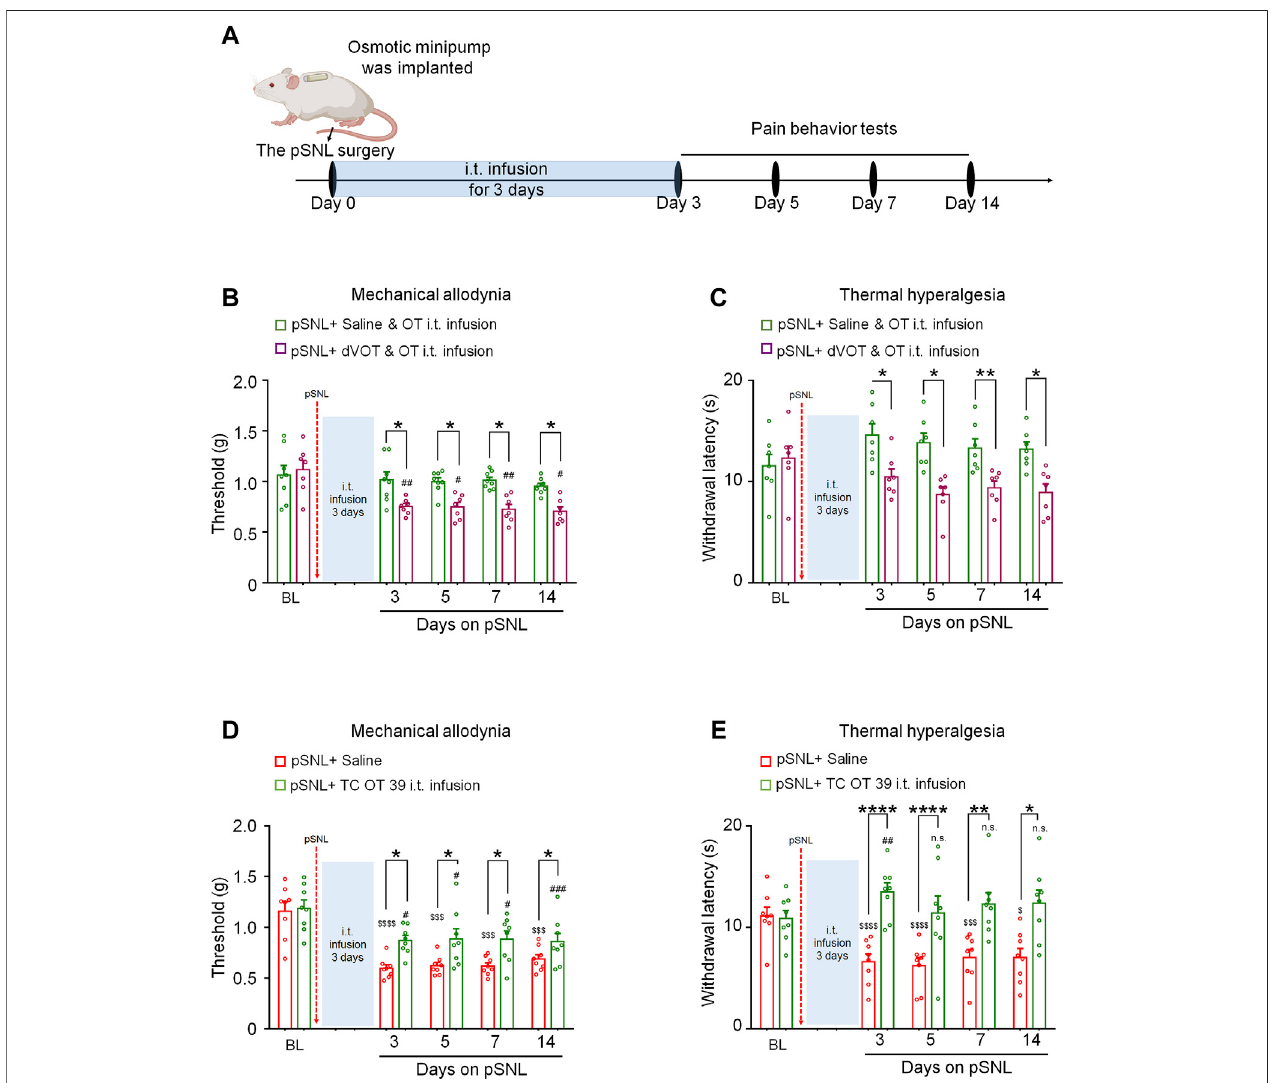
FIGURE 2 | The effects of 3-days OT infusion on nerve injury-induced nociceptive behaviours were mediated by OXTRs. (A) A schematic of the experimental design. (B,C) OT ’ s effect on mechanical allodynia (B) and thermal hyperalgesia (C) was completely blocked by its selective antagonist, dVOT (0.3 μ g/100 μ L). (D,E) Selective OT receptor agonists, TC OT (0.3 μ g/100 μ L, intrathecal infusion) showed similar effects on mechanical allodynia (D) and thermal hyperalgesia (E) in pSNL mice.Two-wayrepeated-measuresANOVAwithgroupasthebetween-subjectsfactor.Dataareexpressedasmean±SEM.* p < 0.05,** p < 0.01,*** p < 0.001TC OT vs. saline; OT vs. dVOT and OT. $$$ p < 0.001, $$$$ p < 0.0001 vs. baseline; # p < 0.05, ## p < 0.01, ### p < 0.001 vs.